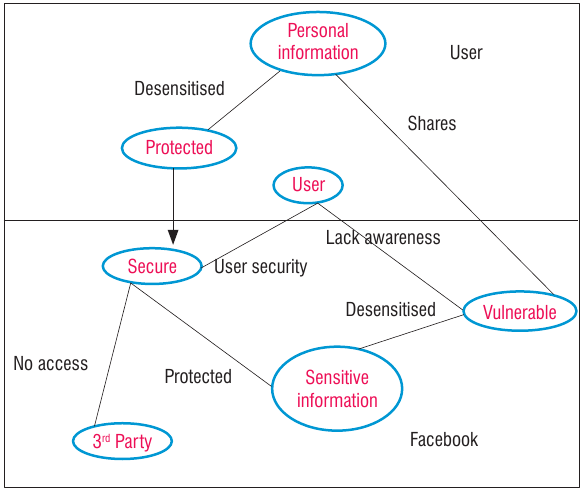
Figure 9: Model of the responsibilities of online